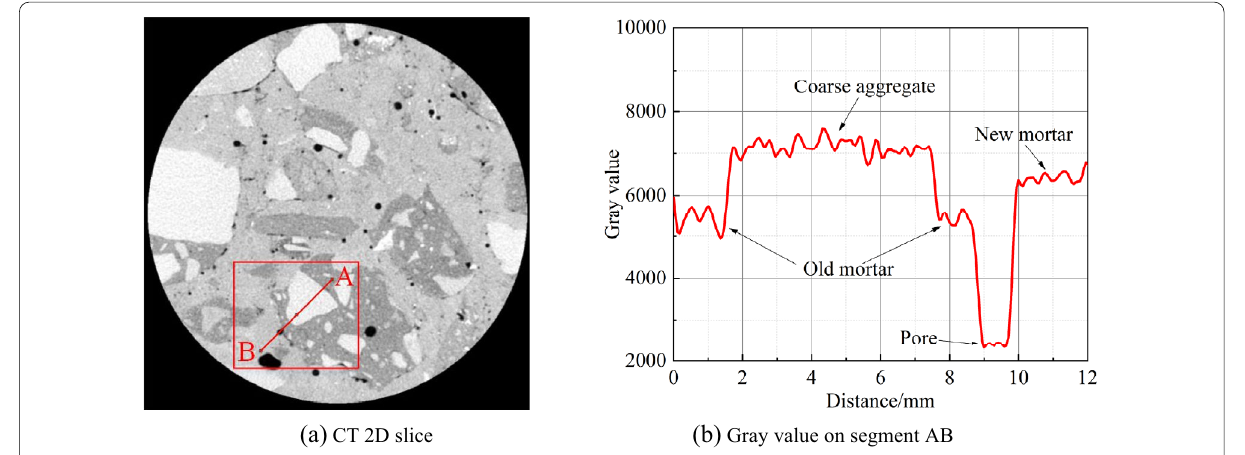
Fig. 4 Division of gray scale for each component of RAC